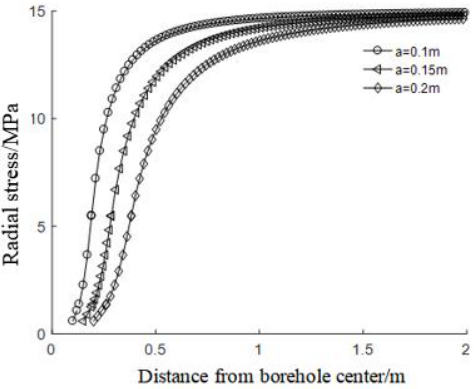
Figure 5. The change in radial stress around borehole under different borehole radiuses.